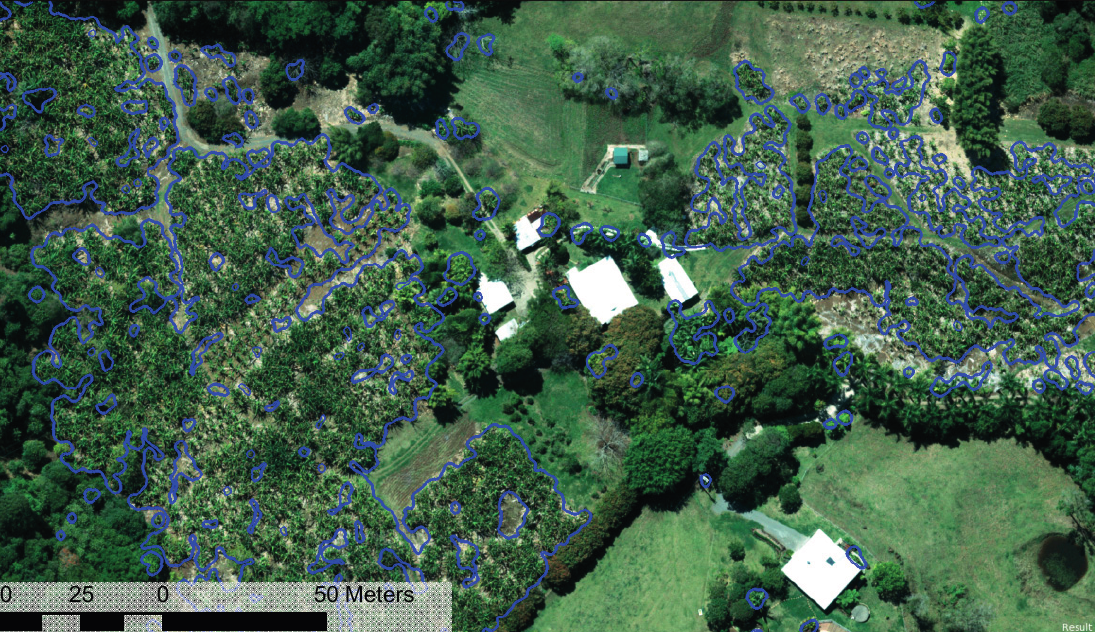
Figure 9. Banana plantation outlined by blue lines. Location: 152°53 ′ 50 ″ E, 26°41 ′ 25 ″